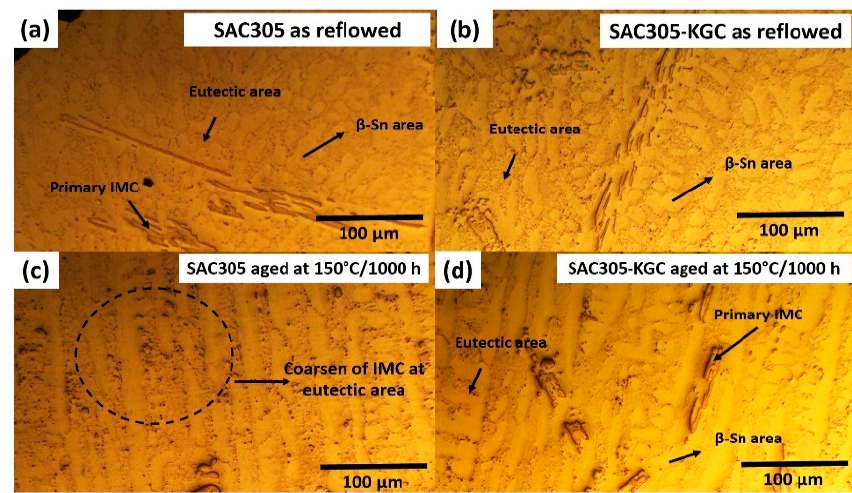
Figure 5. Microstructure at the bulk solder for ( a ) non-reinforced SAC305 as reflowed, ( b ) SAC305-KGC as reflowed, ( c ) SAC305 aged at 150 °C for 1000 h and ( d ) SAC305-KGC aged at 150 °C for 1000 h. The intermetallic compound (IMC) at the interfacial was investigated based on the average thickness and morphology of IMC layer. Figure 6 shows the cross-sectional images of non-reinforced SAC305 and SAC305-KGC composite solders prior to reflow soldering process. Based on Figure 6a, the morphology of interfacial IMC layer in non- reinforced SAC305 solder had an elongated and rounded scallop of Cu 6 Sn 5 . Meanwhile, the morphology of the interfacial IMC layer in SAC-KGC composite solder had rounded scallop Cu 6 Sn 5 and the formation of elongated scallop Cu 6 Sn 5 was not observed. According to our previous study, the elongated scallop was formed due to the increase in concentration of Cu atoms from the substrates, diffusing and reacting with Sn, forming elongated scallop Cu 6 Sn 5 [17]. However, in this research Cu 3 Sn layer was not be observed on the sample of non-reinforced SAC305 and SAC305-KGC composite solders after reflow soldering due to the significantly thinner layer. The Cu 3 Sn phase is known to be formed during the reaction between Sn-Cu/Cu after reflow soldering as reported by Feng et al. [25].